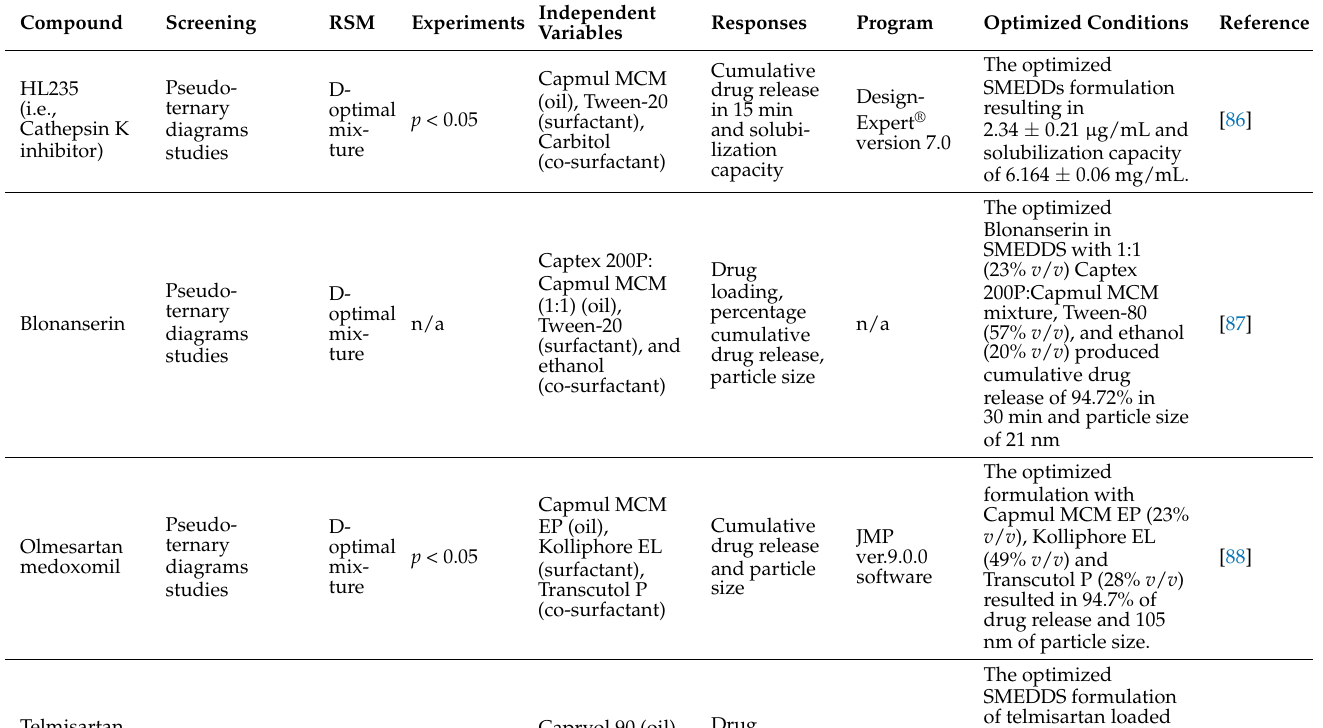
Table 7. List of the SMEDDS developments along with the applied response surface methodology (RSM) of D-optimal mixture